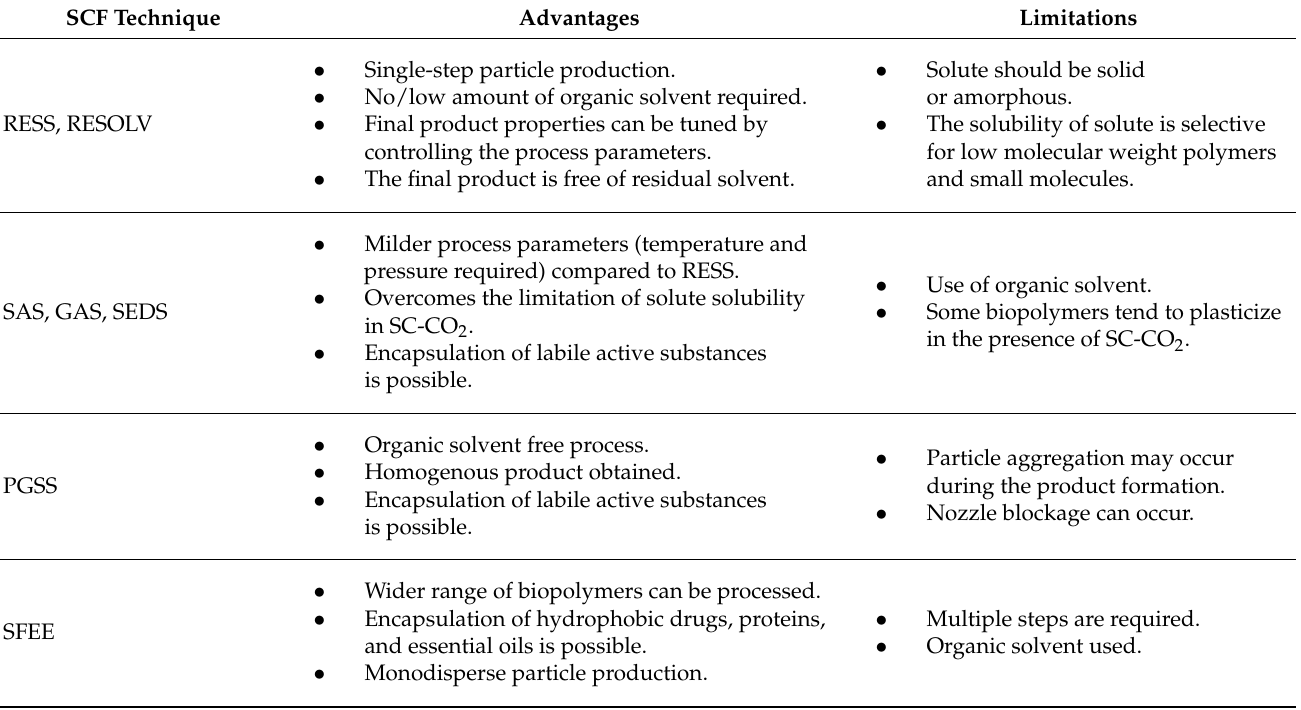
Table 1. Overview of advantages and limitations of the SC-CO 2 -based techniques